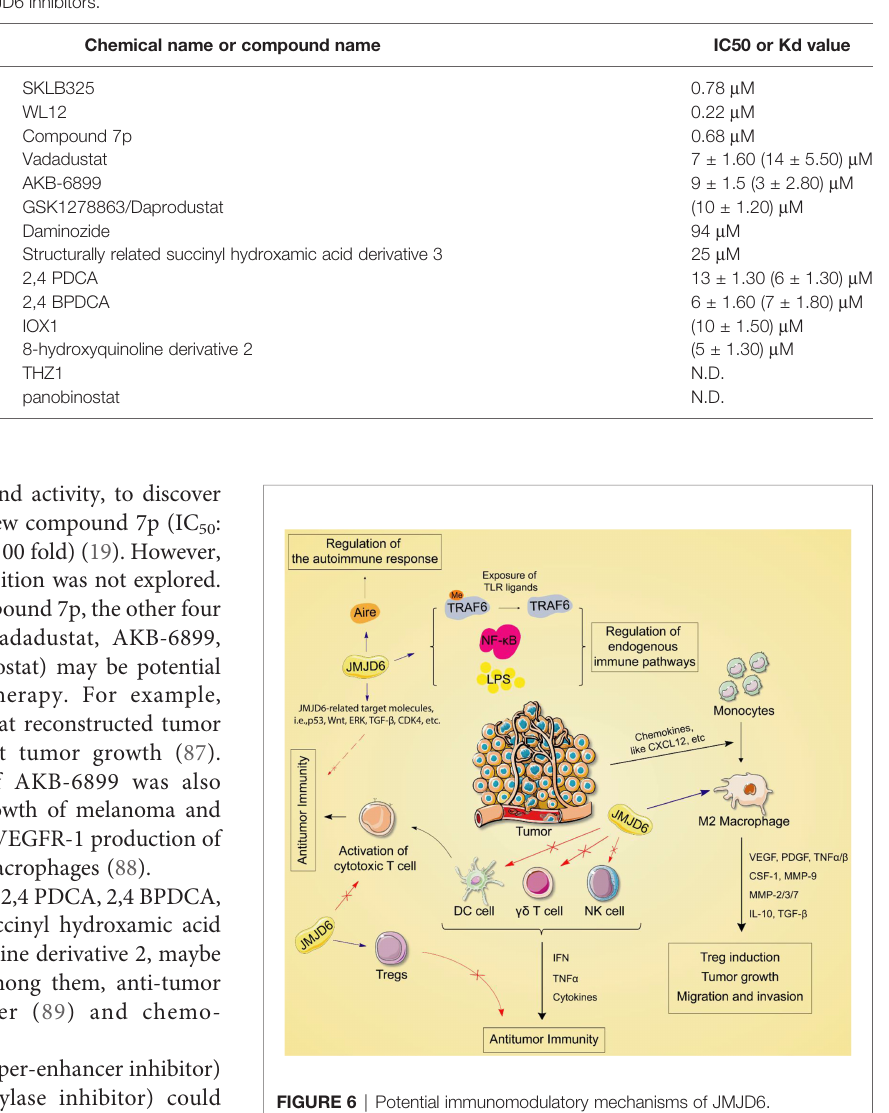
FIGURE 6 | Potential immunomodulatory mechanisms of